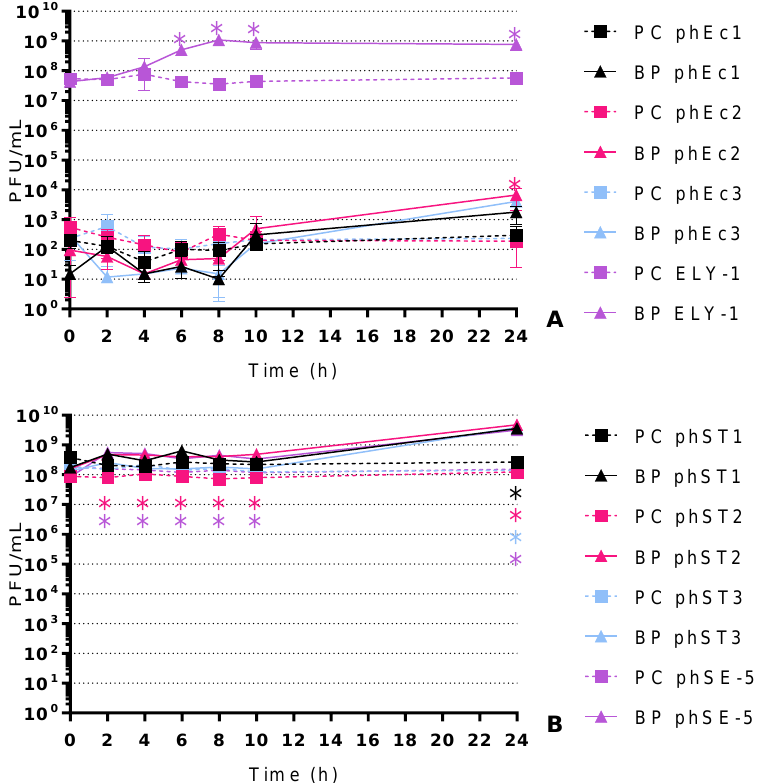
Figure 4. Phage concentration of E. coli phages (phEc1, phEc2, phEc3 and ELY-1) in the presence of E. coli ( A ) and S. Typhimurium phages (phST1, phST2, phST3 and phSE-5) in the presence of S. Typhimurium ( B ) at an MOI of 10 for 24 h: PC-Phage Control; BP-Bacteria plus Phage. Values represent the mean of three independent assays; error bars represent the standard deviation. * p < 0.05 (relative to the respective control).